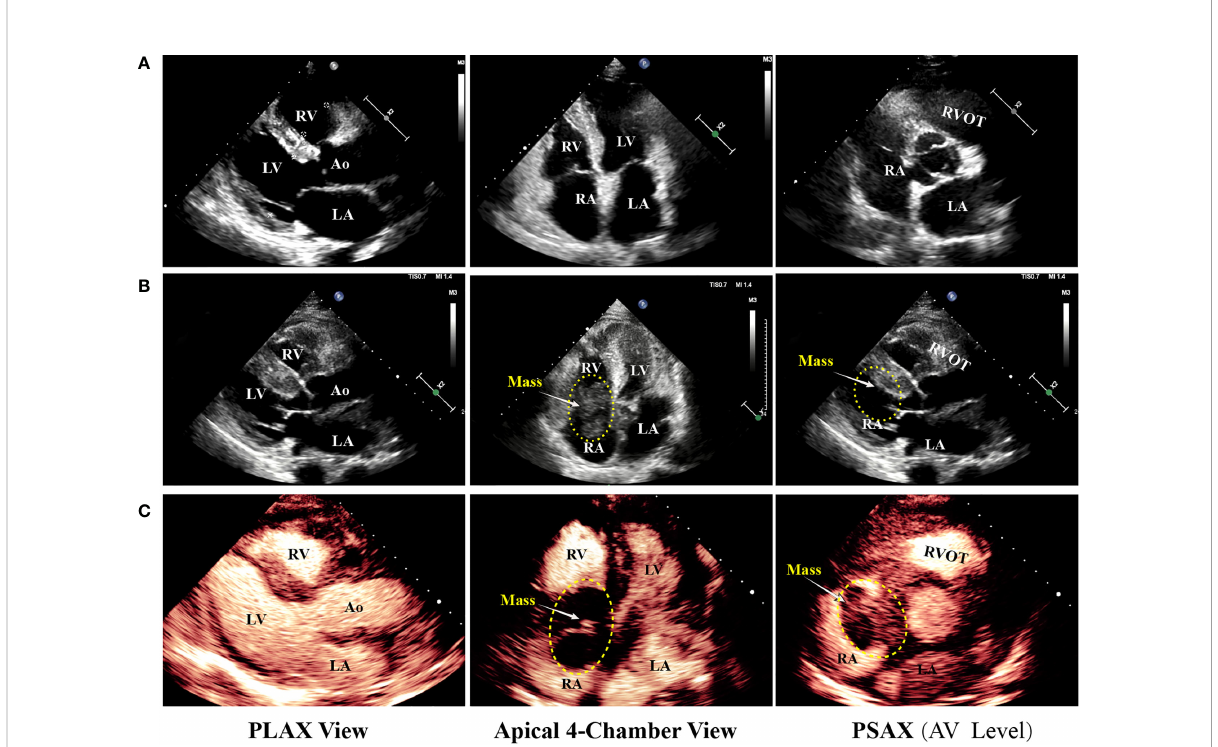
FIGURE 1 Echocardiography progression of the patient. (A) The patient underwent echocardiography 2 months prior to the present hospitalization, and no remarkable abnormality was revealed. (B, C) Regular TTE and myocardial contrast echocardiography showing tumor extending from the right atrium to the right ventricle through the tricuspid valve. LA, left atrium; LV, left ventricle; RA, right atrium; RV, right ventricle; Ao, aorta; RVOT, right ventricular out fl ow tract; PLAX, parasternal long axis; PSAX, parasternal short axis; AV, aortic